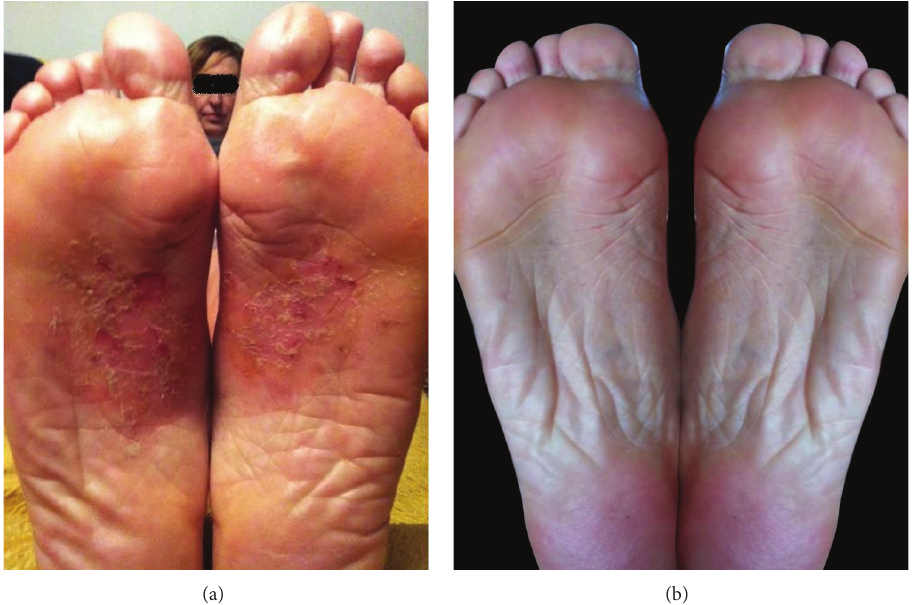
Figure 1: (a) Foot dermatitis before diagnosis of Toxocara infections. (b) Foot dermatitis after antiparasitic treatment.